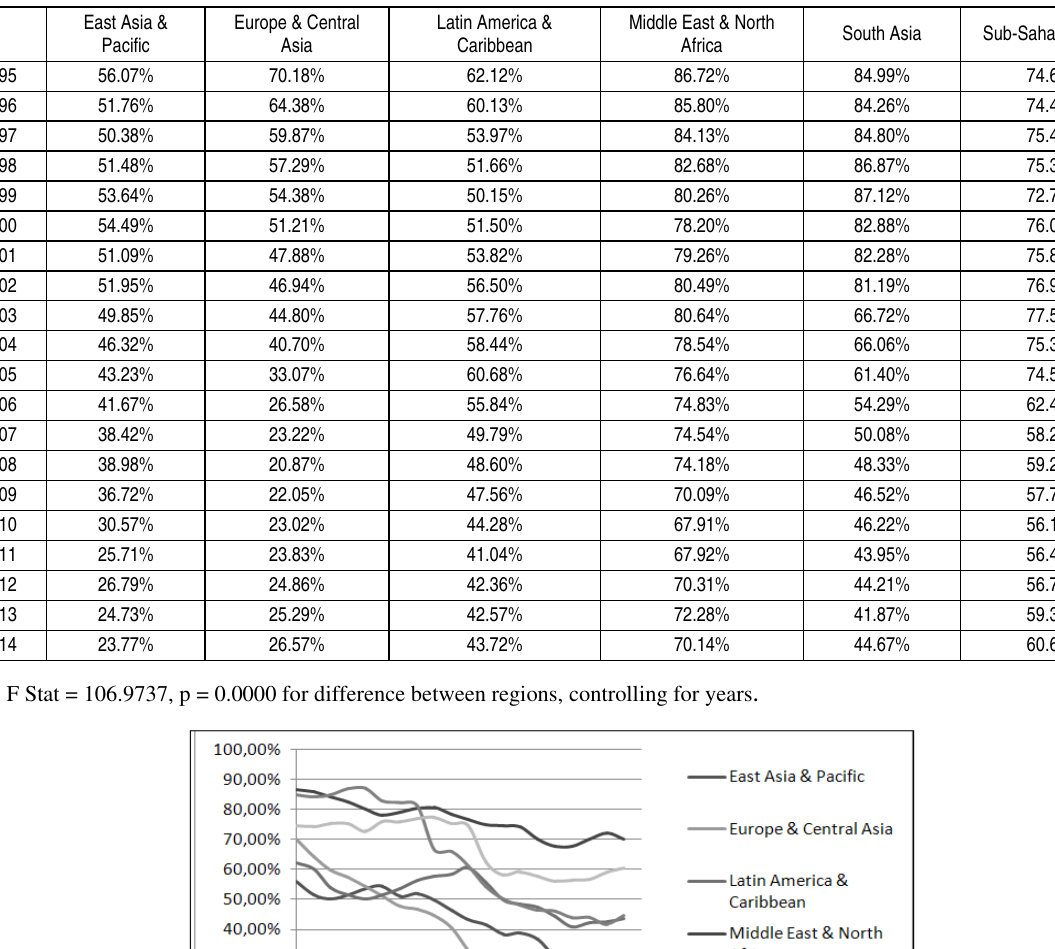
Table 2. Trends in PPG external debt as a percentage of total gross external debt region-wise